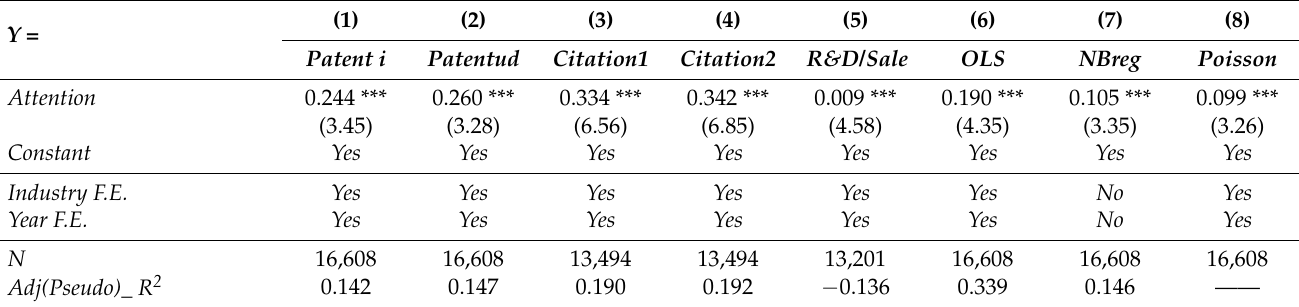
Table 5. Robustness